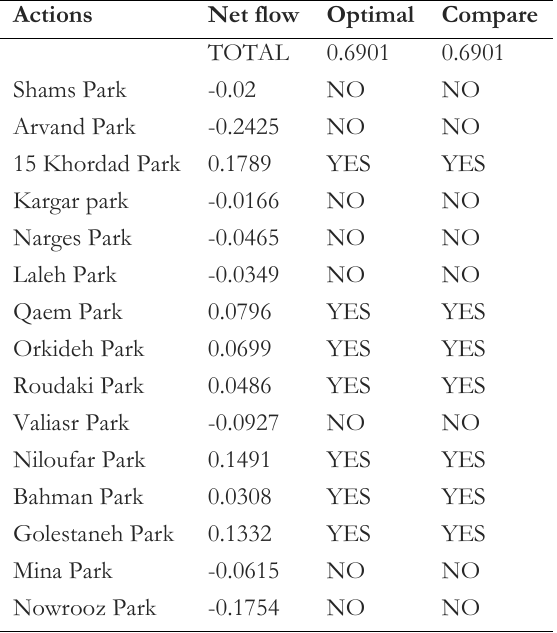
Table 6. Optimal options evaluated by PROMETHEE